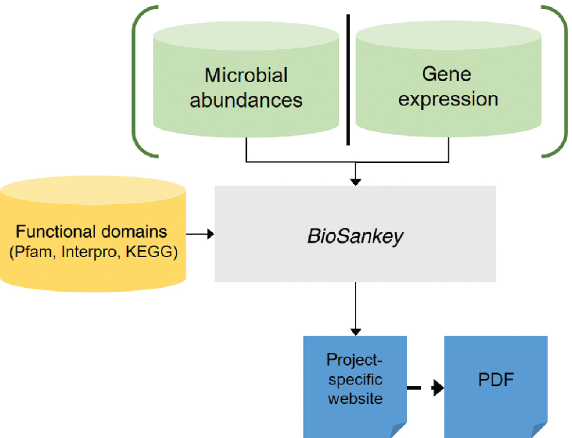
Figure 1: The workflow of the tool BioSankey : the green items on top, “ microbial abundances ” and “ gene expression ” , are alternative inputs, the yellow item on the left is optional information and the blue sheets at the bottom are the output, where the dashed arrow to “ PDF ” is an optional